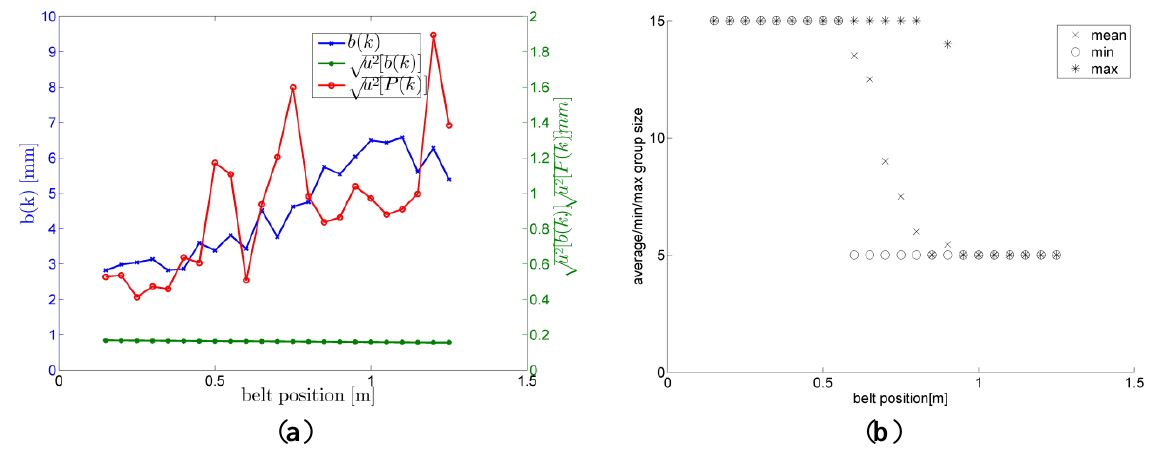
Figure 19. ( a ) Mean error from reference points; ( b ) Size of groups at different positions.